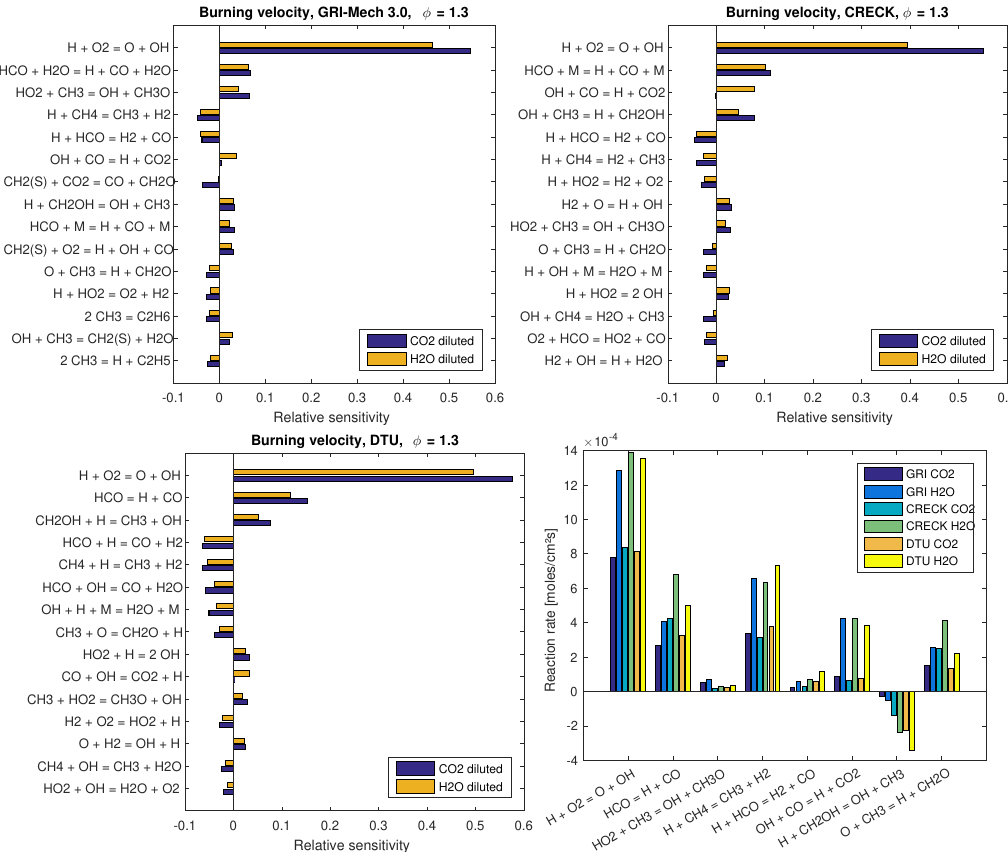
Figure 4. Sensitivity analysis on the laminar flame speed and reaction rates of the different mechanisms evaluated at φ = 1.3. = 0.5, while for H = 0.1. Sensitivity analysis are presented at: ( left-top ) for GRI For CO 2 dilution Z CO 2 O dilution X H 2 O 2 3.0; ( left-bottom ) for DTU; and ( right-top ) for CRECK C1-C3 mechanisms. At ( right-bottom ), reaction rates are